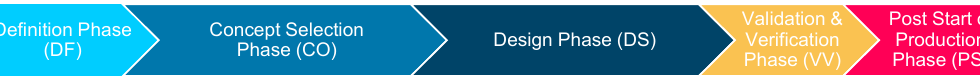
Figure 1. Development phases.